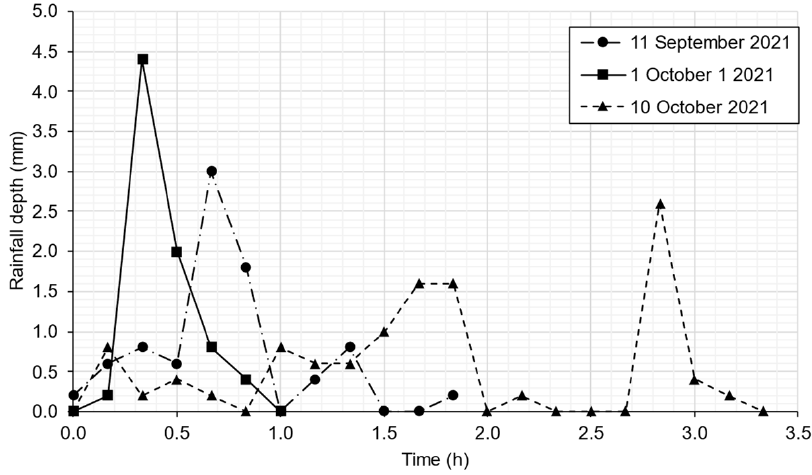
Figure 5. Permeable soils inside the computational domain ( left ). Street view (Google) of boundary walls of permeable soil ( right ).